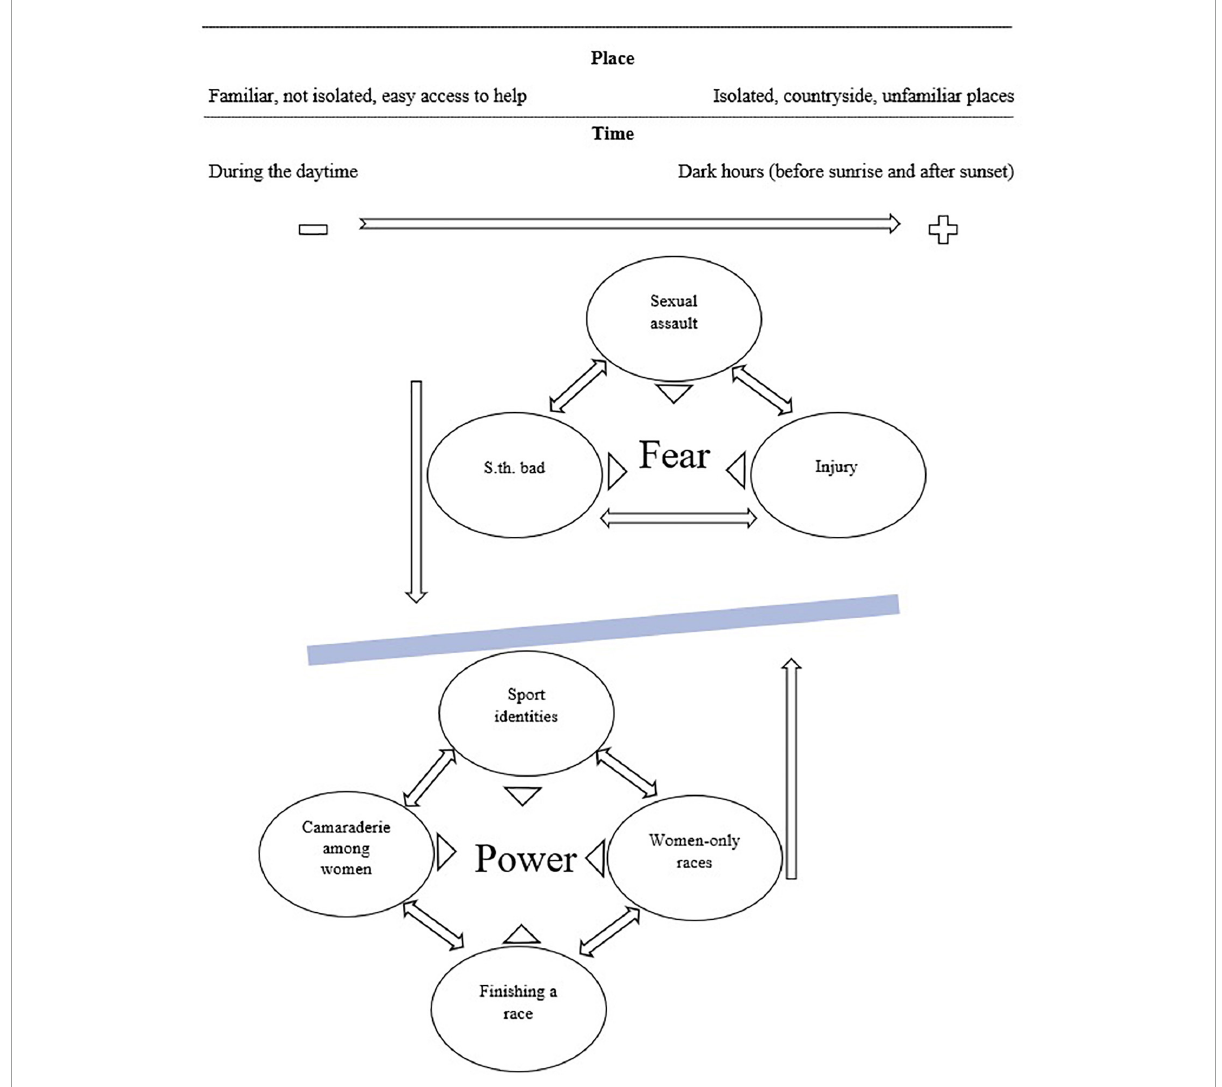
FIGURE1 Grounded theory framework of women’s fear and power within MPSEs.